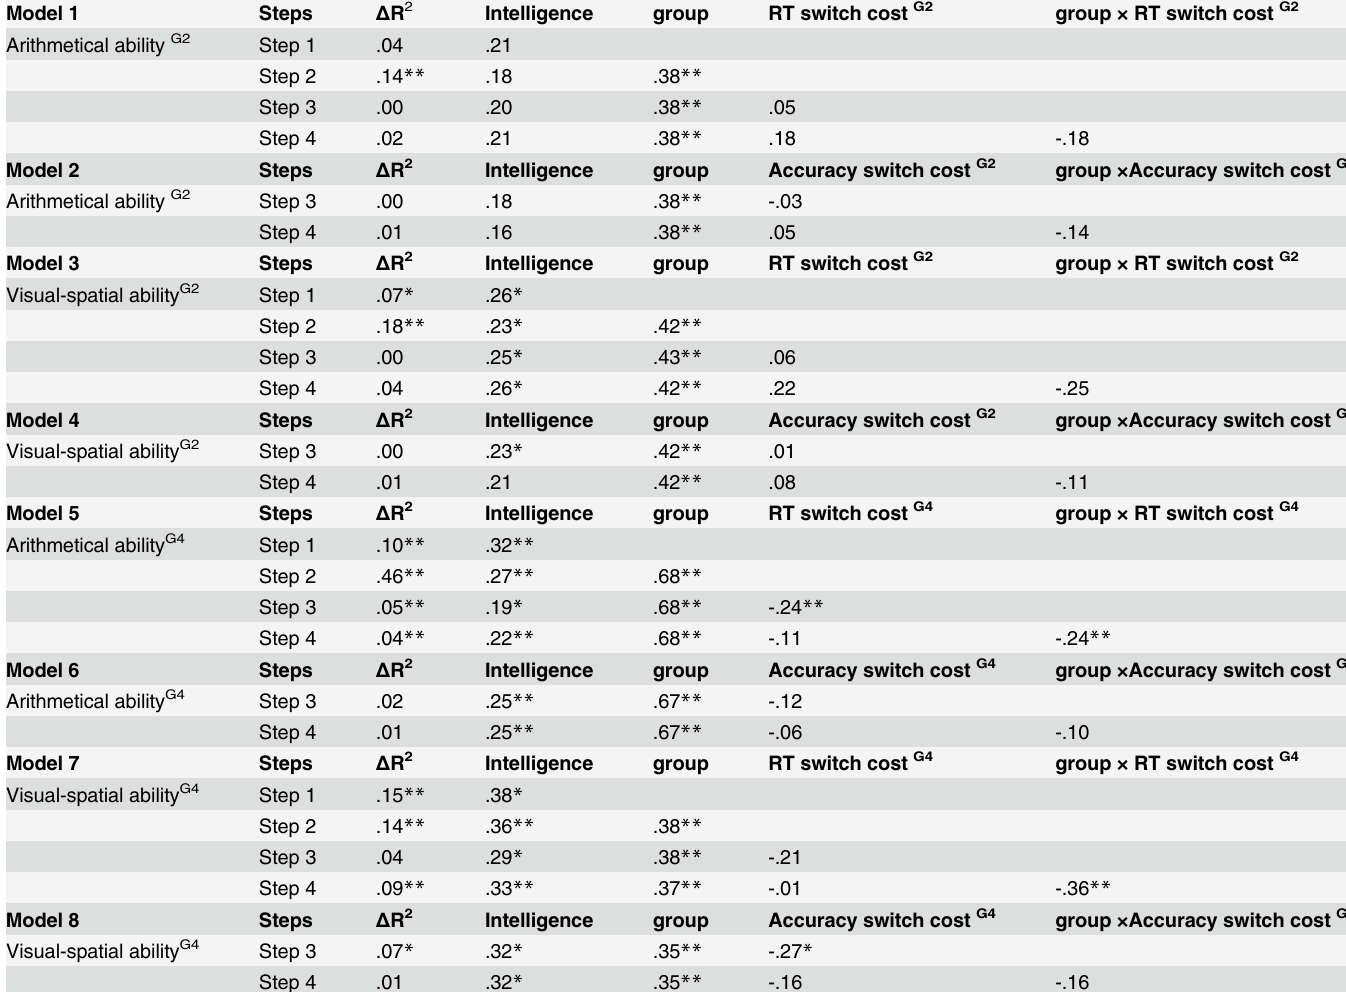
Table 4. Summary of hierarchical regression models using covariates, group, task switching and interactions between group and switch cost as predictors for math abilities. Model